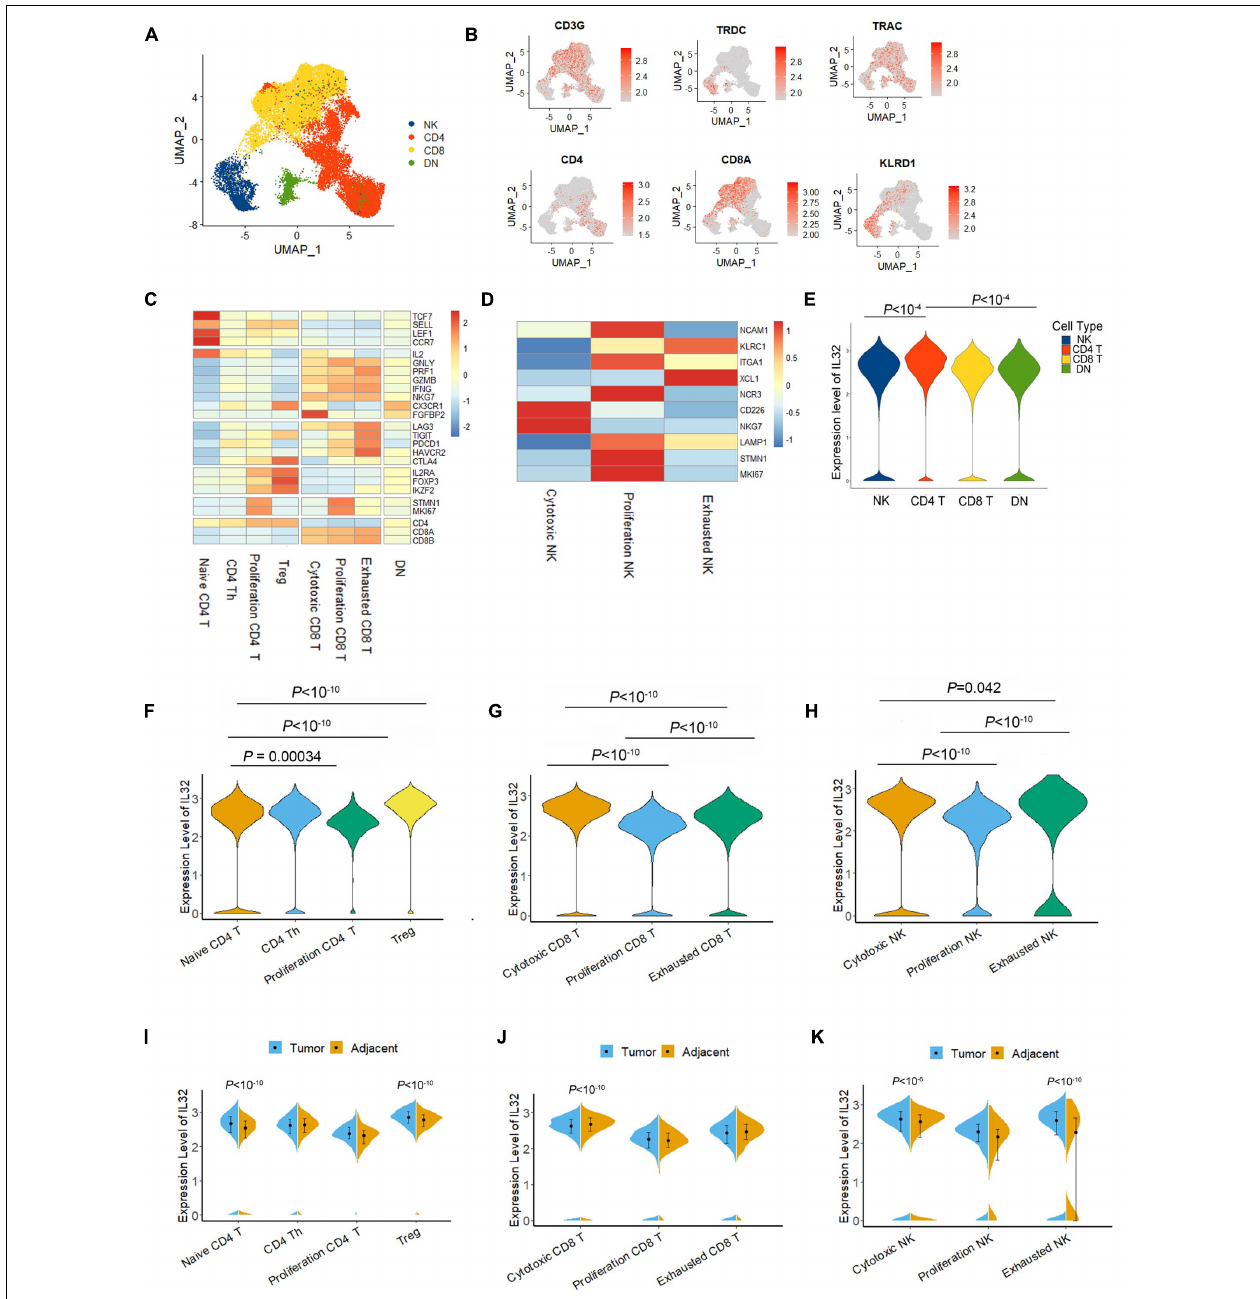
FIGURE 2 | IL-32 expression in subtypes of T and NK cells. (A) UMAP plot of T and NK cells from the tumor tissues of seven ESCC patients, showing the formation of main CD4 + T cells, CD8 + T cells, NK cells, and CD4/CD8 low expression cells (DN). Each dot corresponds to a single cell, colored according to the cell cluster. (B) Expression levels of relative marker genes illustrated as UMAP plots. The expression was measured as the log2 (count + 1). (C) Heatmap of Z score normalized log2 (count + 1) expression of selected T cell function–associated genes in each cell cluster. (D) Heatmap of Z score normalized log2 (count + 1) expression of selected NK cell function–associated genes in each cell cluster. (E) Violin plot compared the IL-32 expression in NK, CD4 T, CD8 T, and DN T cells in the ESCC. The expressions of IL-32 were measured as the log2 (count + 1). (F) Violin plot shows the IL-32 expression among naive CD4 T, CD4 Th, proliferation CD4, and Treg cell subsets in ESCC. (G) Violin plot shows the IL-32 expression in cytotoxic CD8, proliferation CD8, and exhausted CD8 T cells in ESCC. (H) Violin plot shows the IL-32 expression in cytotoxic NK, proliferation NK, and exhausted NK cell subsets in ESCC. p Value adjustment was performed using Bonferroni correction and then was calculated by Wilcoxon signed rank test for panels (E–G) . (I) Violin plot shows the IL-32 expression in tumor and adjacent CD4 T cell subsets. (J) Violin plot shows the IL-32 expression in tumor and adjacent CD8 T cell subsets. (K) Violin plot shows the IL-32 expression in tumor and adjacent NK cell subsets. The expression of above figures was measured as the log2 (count + 1). Each plot represents the interquartile range (IQR, the range between the 25th and 75th percentile) with the midpoint of the data. p Value was calculated by Wilcoxon signed rank test.